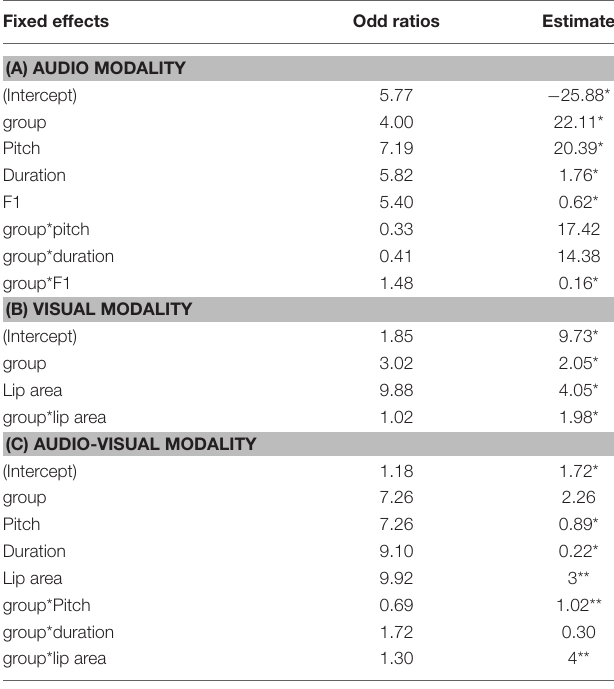
TABLE 2 | Results of linear mixed effects logistic regressions performed on perceptual responses (for the group variable, ref =